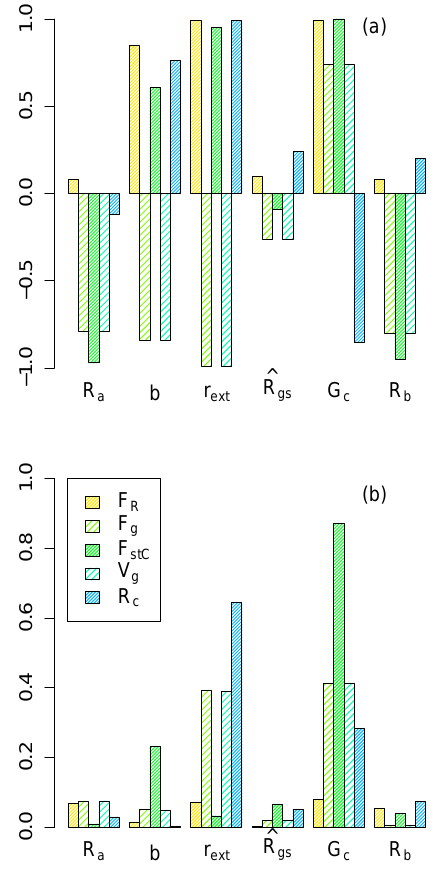
Figure 3. (a) Mean partial correlation coefficients and (b) strength of the correlation in % per %. R a , b , r ext , ˆ R gs , and G c are perturbed within ± 20% of their central estimate. Results from simulations at the FLUXNET site FI-Hyy for the simulation period